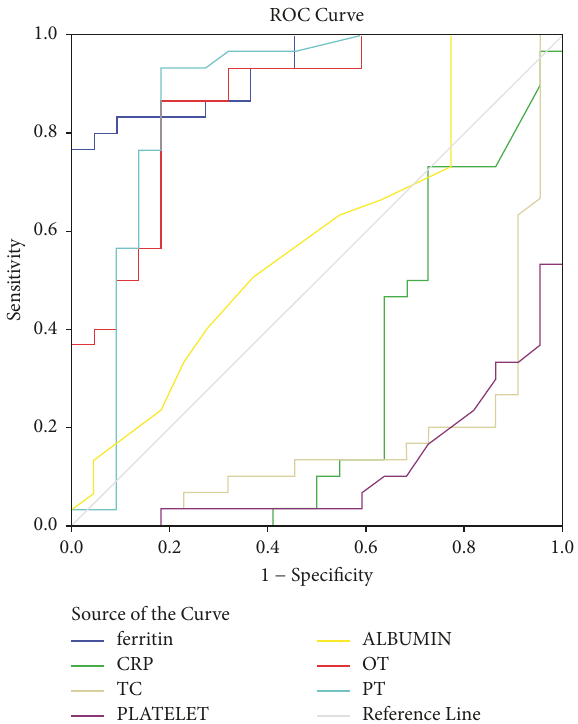
Figure 1: Receiver operating characteristic curve for identifying dis- criminating predictors of dengue. Diagonal segments are produced by